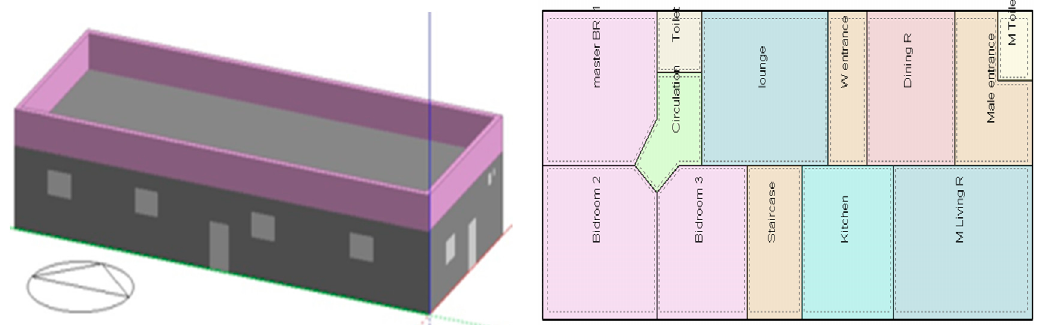
Figure 6. The plan and geometric description of House 2.